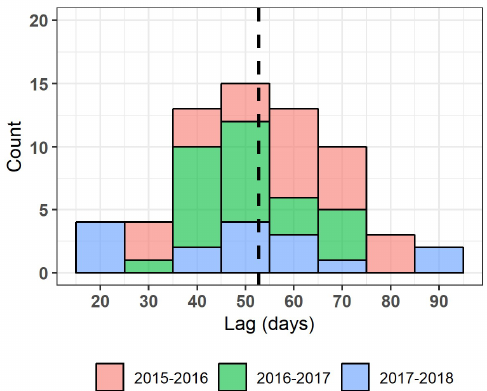
Figure 4. Histogram of lags between SMAP SM and LFM of three water years (2015–2016, 2016–2017, 2017–2018) across 12 sites used in the study. Mean length of lag was marked using the dashed